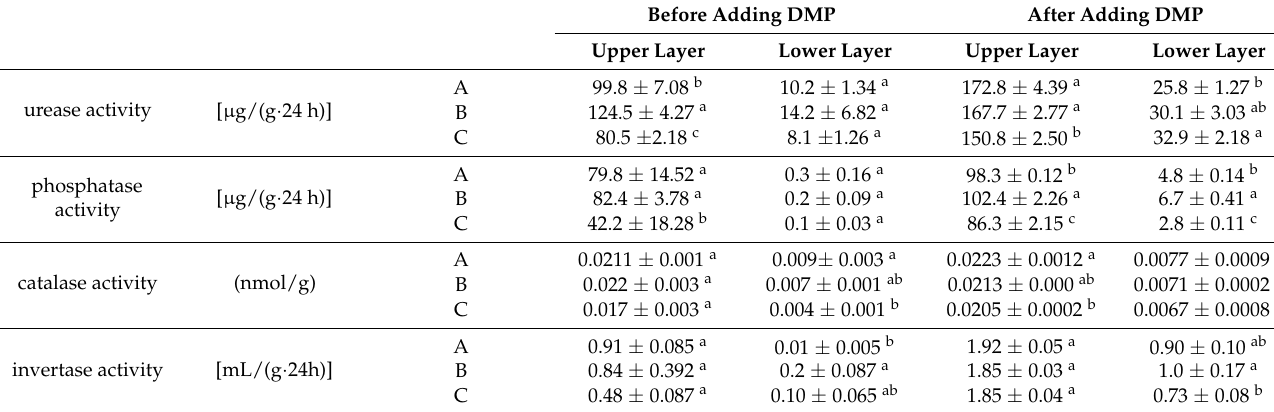
Table 3. Enzyme activity of substrate in the three VFCWs. Before Adding DMP After Adding DMP Upper Layer Lower Layer Upper Layer Lower